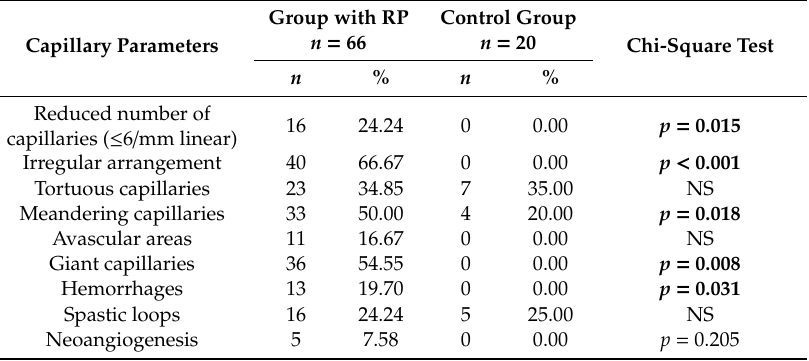
Table 1. Qualitative capillary parameters in the group of patients with Raynaud’s phenomenon (RP) and in the control group. Group with RP n = Capillary Parameters